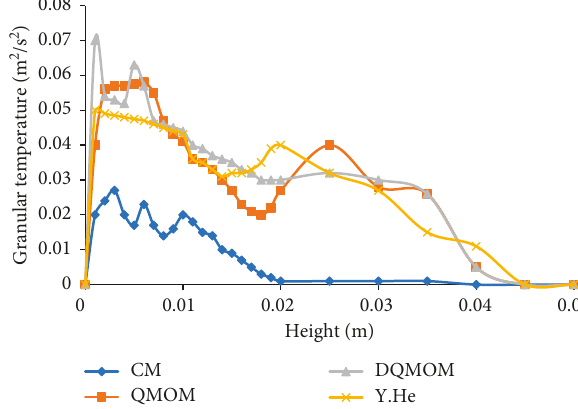
Figure 7: The plunging pressure along the radical distance h � 0.04m on the nozzle outlet section.